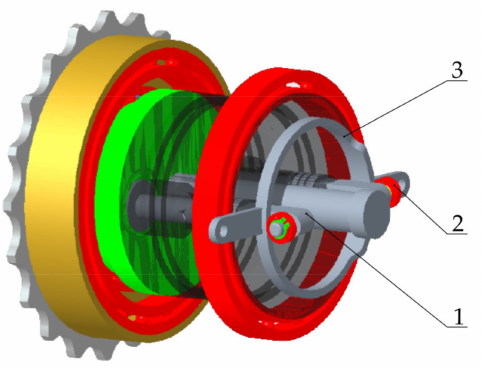
Figure 8. Two-dimensional diagram of fertilizer needles in the soil and out of the soil.